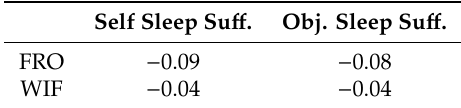
Table 5. Mediation e ff ect size of life